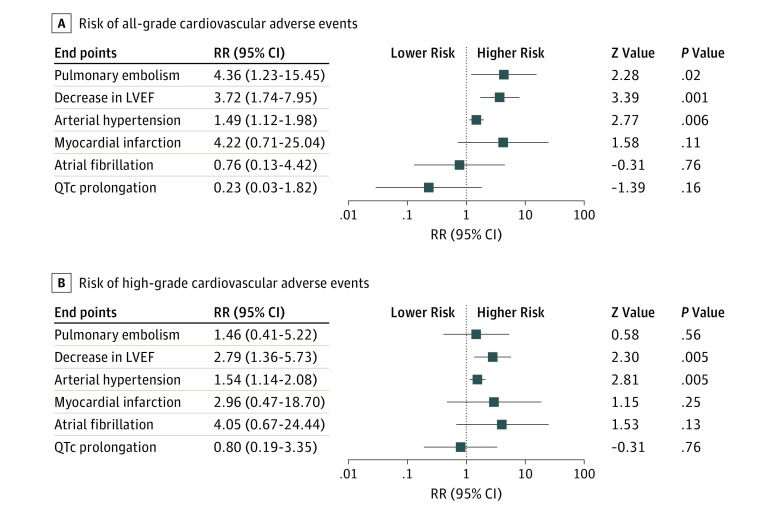
Overall Study Estimates of the Risk Ratio (RR) of Cardiovascular Adverse Events Associated With BRAF and MEK Inhibitor Treatment vs BRAF Inhibitor MonotherapyLVEF indicates left ventricular ejection fraction.